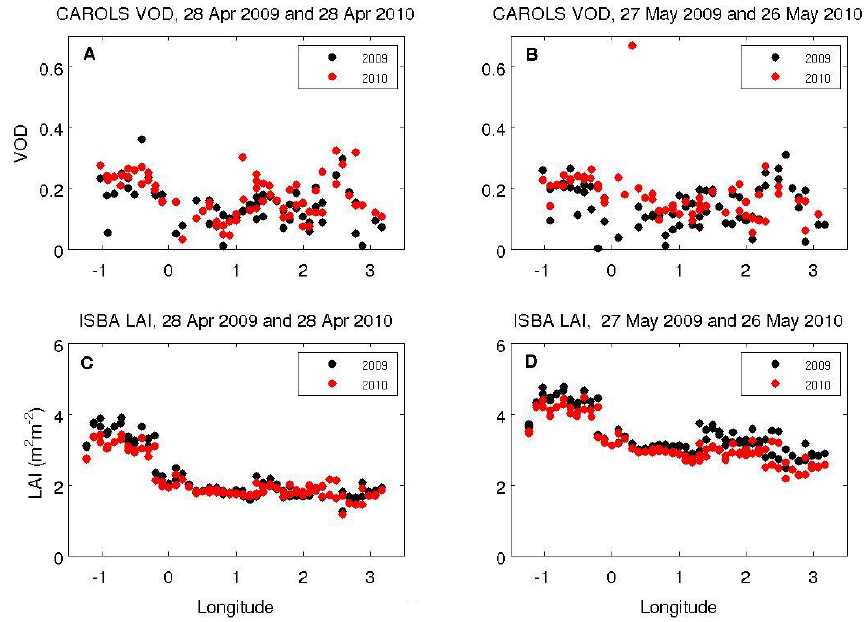
Fig. 7. Flight transect of (A, B) the vegetation optical thickness (VOD) retrieved from CAROLS Tb and of (C, D) the ISBA-A-gs LAI simulations, at (A, C) the end of April 2010, and (B, D) the end of May